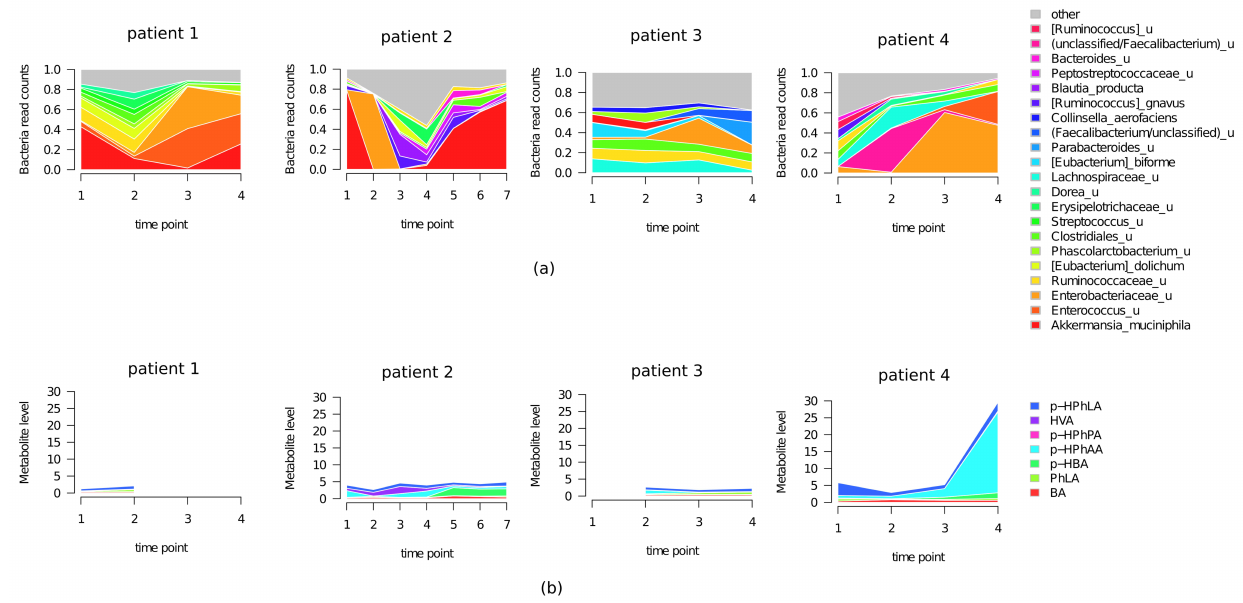
Figure 3. Temporal dynamics (time points) of microbiome composition ( a ) and metabolic ( b ) profile for patients 1, 2 with positive and patients 3,4 with negative